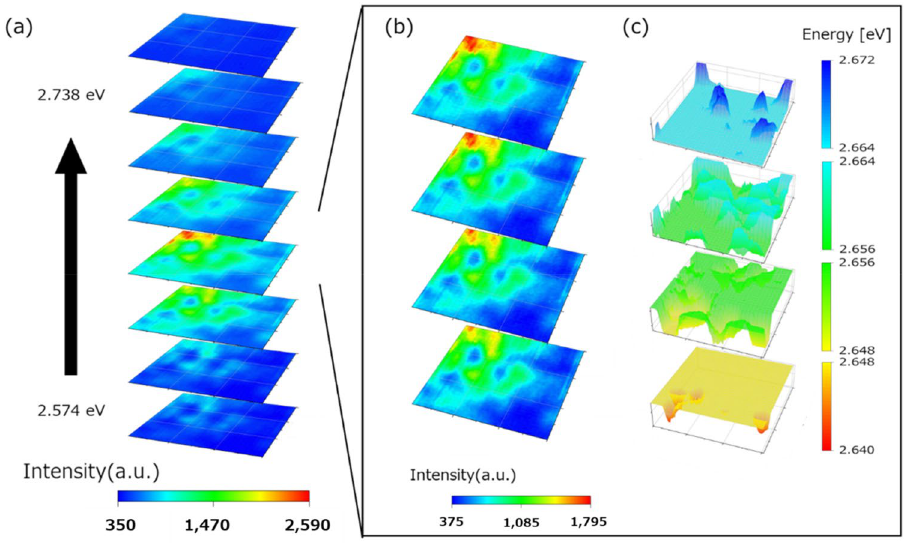
Figure 6. Sliced the integral intensity map obtained from the C-mode operation. ( a ) Sliced every 21 meV map of the main emission energy range. ( b ) More finely (every 8 meV) sliced map within the range of change in the emission centre energy. ( c ) Slices of the three-dimensional emission centre wavelength map. Each slice of ( b ) and ( c ) has the same energy range.